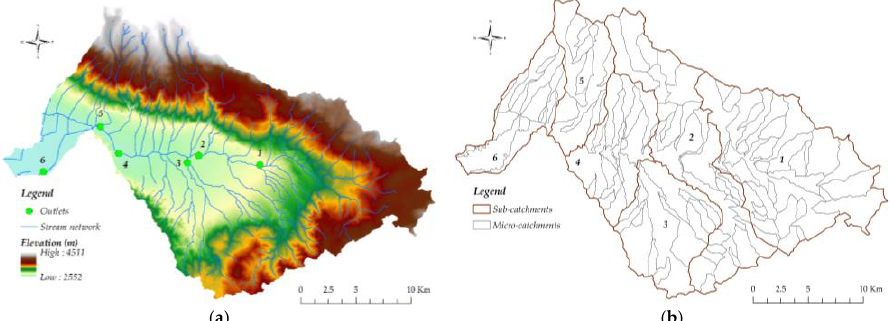
Figure 2. ( a ) Elevations, outlets and stream network and ( b ) sub-catchments and micro-catchments in the Rocha River